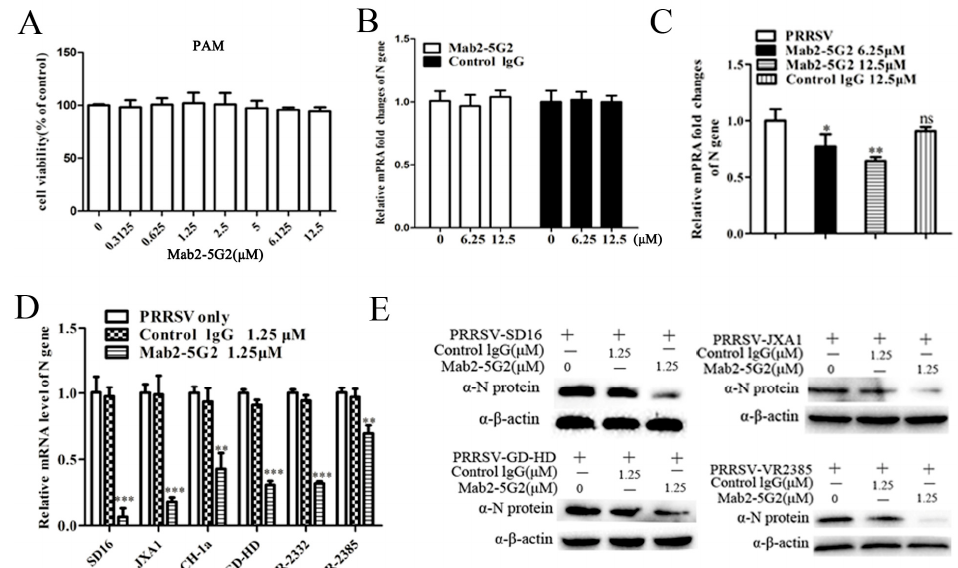
Figure 3. Mab2-5G2 treatment blocks porcine reproductive and respiratory syndrome virus (PRRSV) internalization. ( A ) Cell viability assay for cytotoxicity of Mab2-5G2 in porcine alveolar macrophages (PAMs). Gradient doses of Mab2-5G2 (0, 0.3125, 0.625, 1.25, 2.5, 5, 6.125, and 12.5 µM) were applied to PAMs for 24 h followed by viability testing of PAMs via Cell Counting Kit-8 (CCK-8) assay. No significant cytotoxicity was observed for Mab2-5G2. ( B ) PAMs were preincubated with Mab2-5G2 (6.25 and 12.5 µ M) then followed by incubation of PRRSV-SD16 strain (10 MOI) under 4 ◦ C for 2 h to allow su ffi cient attachment of virus, then